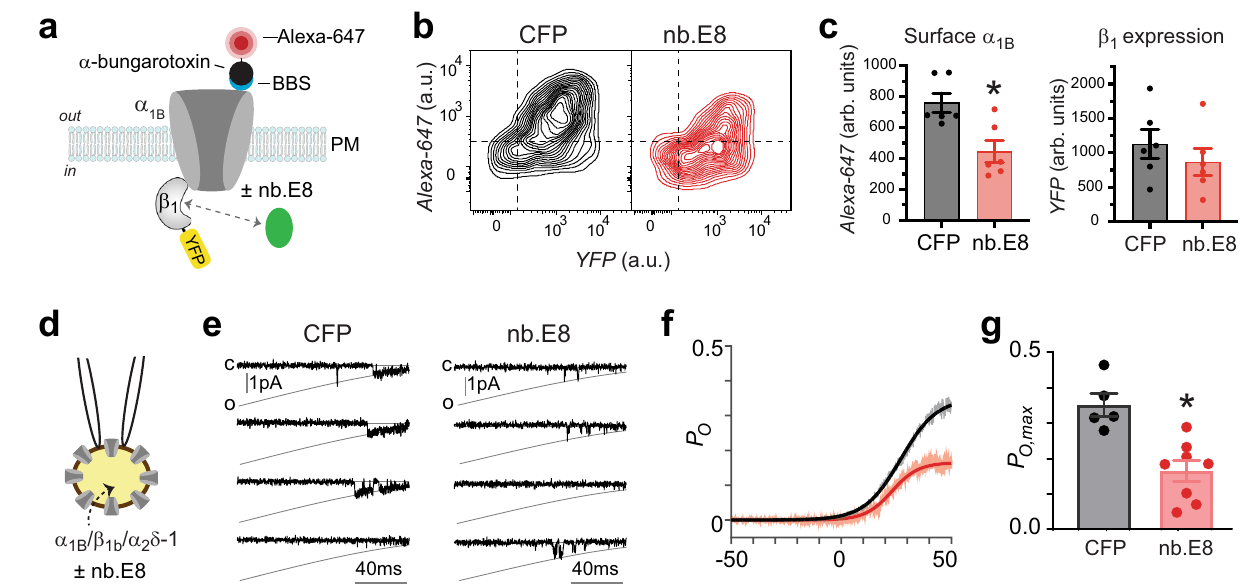
Fig. 5|Nb.E8inhibitsCa V 2.2 surfacedensityandsinglechannel P o .a Schematic of BBS- α 1B + β 1b -YFP±nb.E8. b Flow cytometry contour plots showing Ca V 2.2 surface density (Alexa647) vs β 1b expression (YFP) in HEK293 cells expres- sing α 1B + β 1b + α 2 δ − 1 with either CFP (left) or nb.E8 (right). c Bar charts showing impact of nb.E8 on Ca V 2.2 surface density ( n =6 over 3 independent experiments for both CFP and nb.E8 groups) and β 1b -YFP expression ( n =6 over 3 independent experimentsforbothCFPandnb.E8groups).* P =0.0052comparedtoCFPcontrol, two-tailed unpaired t test. d Schematic of cell-attached single channel recording.